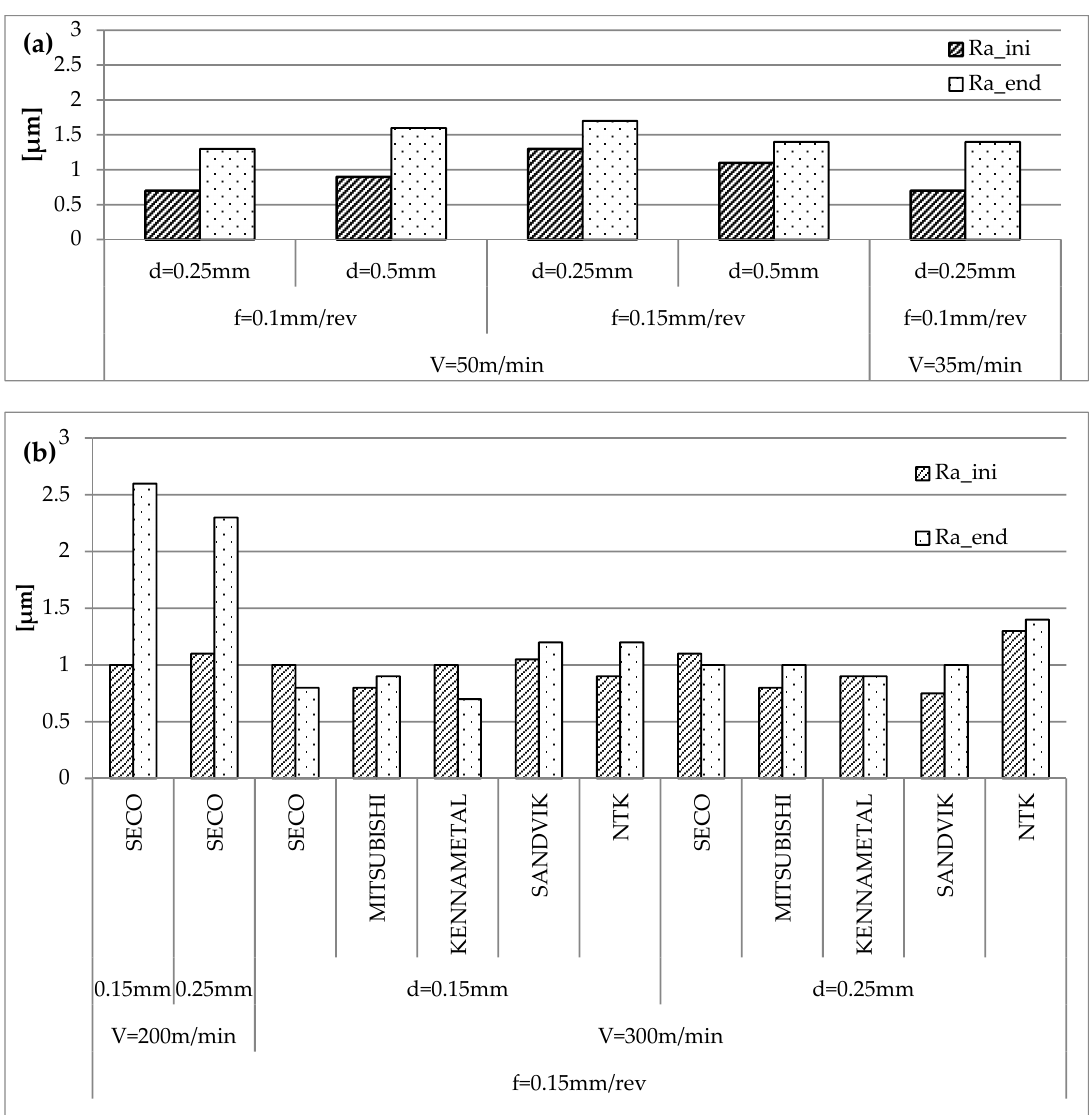
Figure 11. Average roughness (Ra) measured at the beginning of the test (Ra_ini) and at the end of tool life (Ra_end) in turning tests with: ( a ) Seco tool of TS2000 grade and ( b ) PCBN and JP2 grade cutting tools.